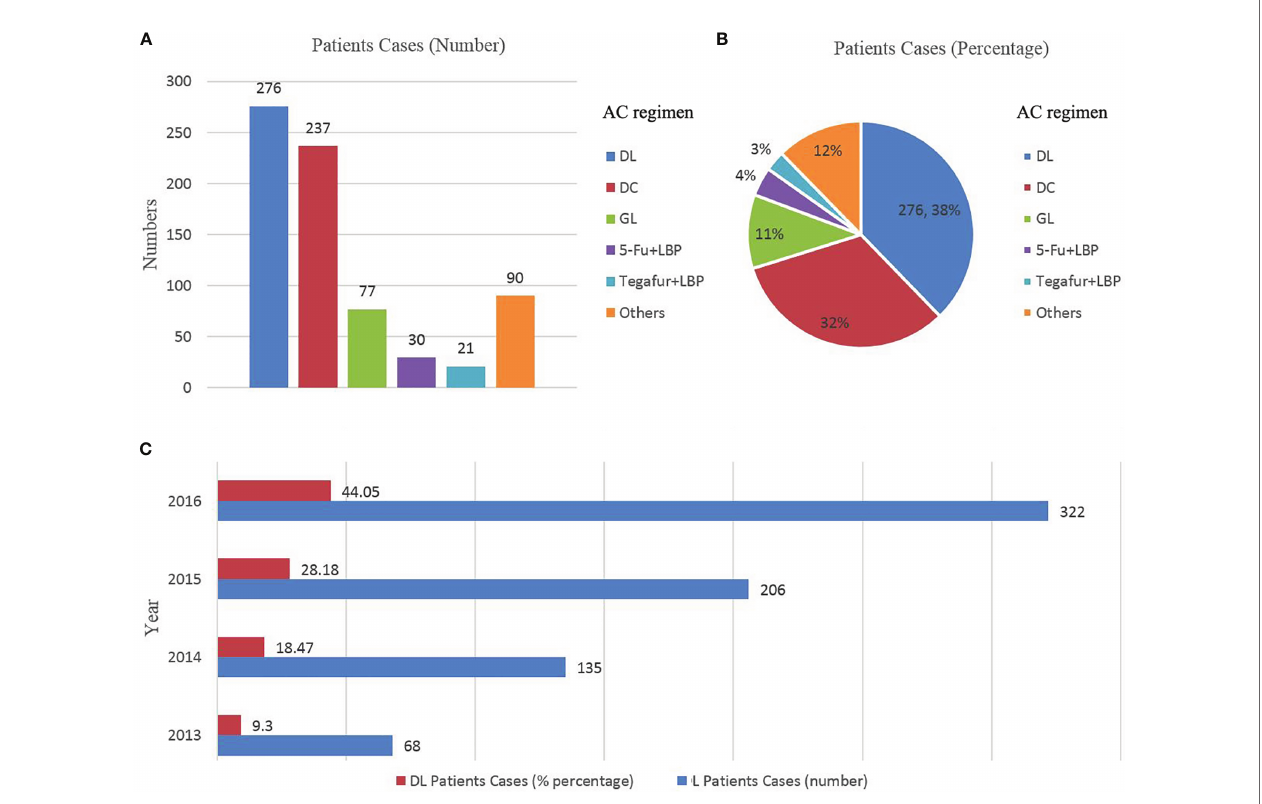
FIGURE 2 | (A, B) , Scheme distribution of the combined lobaplatin regimens (N = 731); (C) Trends in the use of lobaplatin regimens by year, ESCC patients treated with a combined lobaplatin regimen from 2013 to 2016 and its percentage in all ESCC patients after AC (N = 731). DL, docetaxel+ lobaplatin; DC, docetaxel+ cisplatin; GL, gemcitabine + lobaplatin; LBP, lobaplatin; LBP, lobaplatin; N, number; AC, adjuvant chemotherapy; ESCC, oesophageal squamous cell